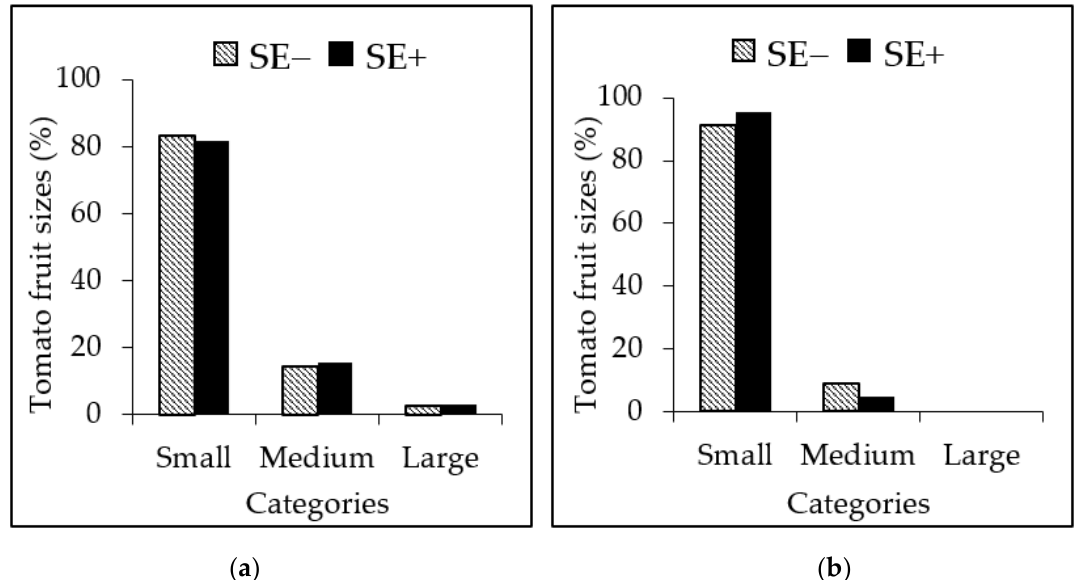
Figure 6. Proportions of tomato fruits according to size at harvest reported as percentages. Plants grown under ( a ) normal conditions (Control) and ( b ) under salinity stress conditions (300 mM NaCl) with the application of the P. gymnospora extract (0.2%; SE+) and without the extract (SE − ). Fruit size and mass categories for small (2.5–3.4 cm and 20–59 g), medium (3.5–4.4 cm and 60–83 g), and large (4.5–5.4 cm and 84–100 g) tomato fruits were used to classify fruits at harvest.